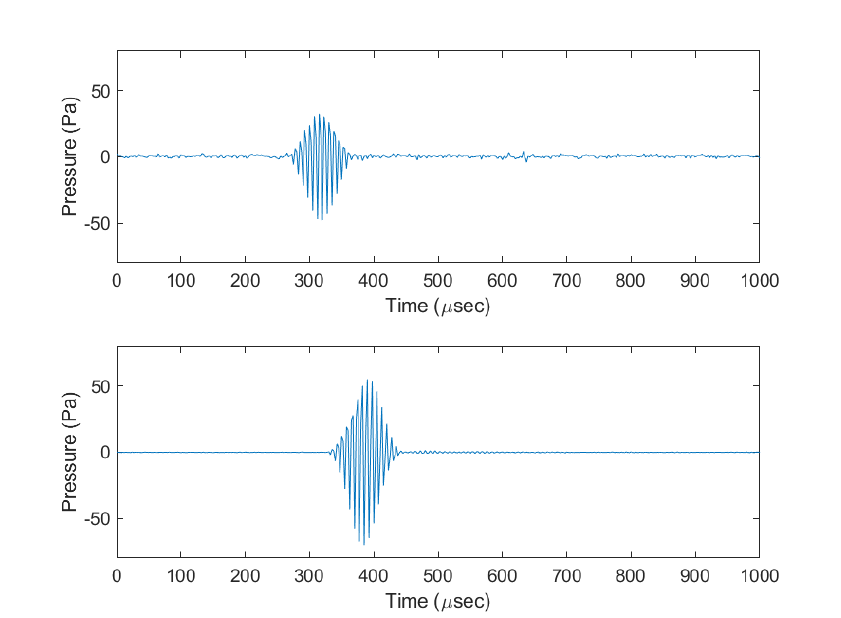
Figure 12. Time domain signal of a single click recorder by the PorpDAQ ( top ) and the reference system ( bottom ). The waveform shown at the top has a recorded peak frequency of 131.8 kHz while the bottom waveform is recorded at 129.7 kHz.